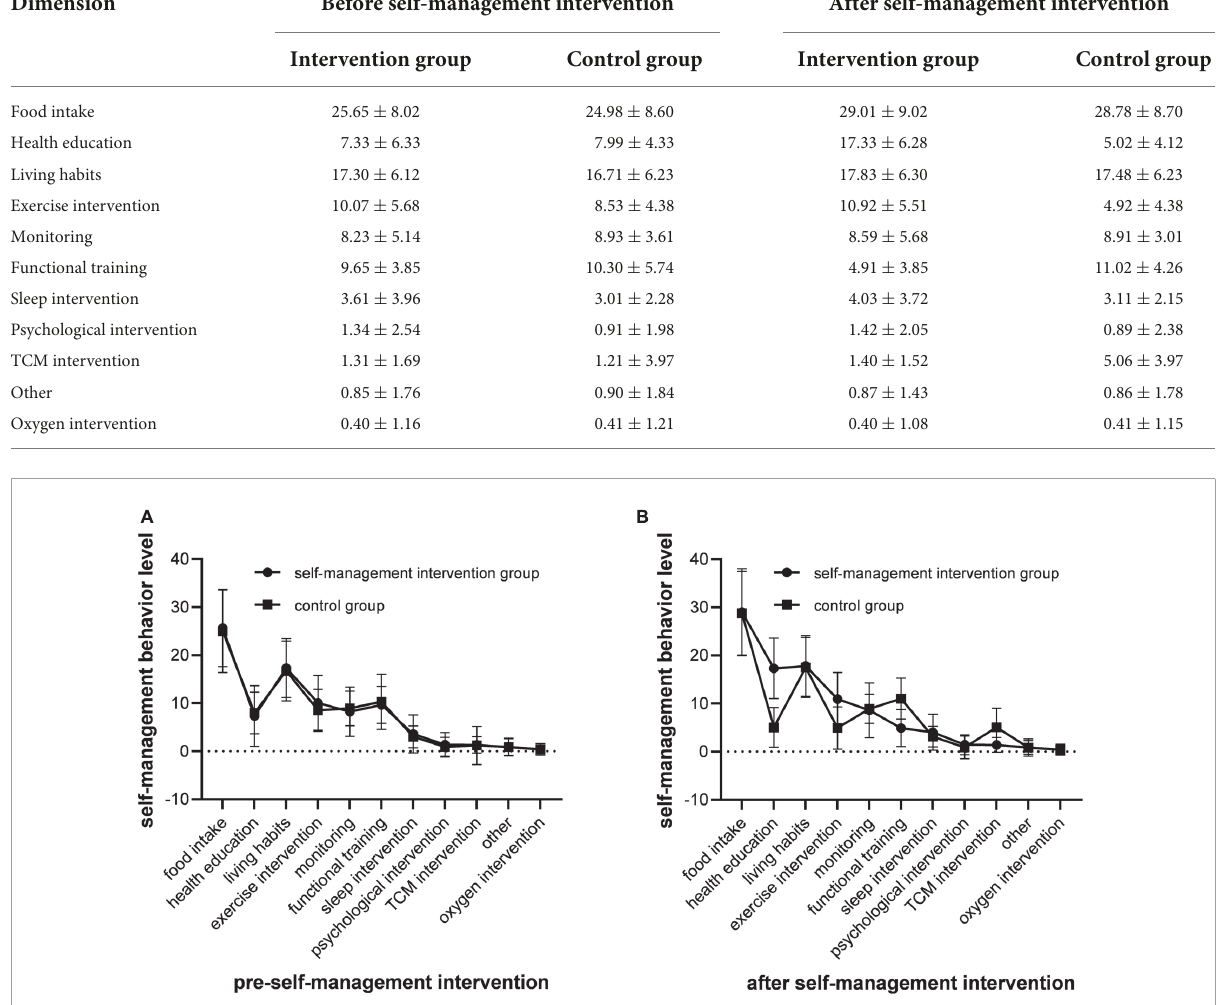
FIGURE2 Self-management evaluation results comparison. (A) The scores of self-management behaviors were no significant difference among different groups ( P > 0.05), the dimension scores of self-management intervention were no statistical difference between the other groups (all P > 0.05). (B) The scores of self-management behaviors were statistically significant differences among different groups ( P < 0.05), the dimension scores of self-management intervention were no statistical difference between the other groups (all P >